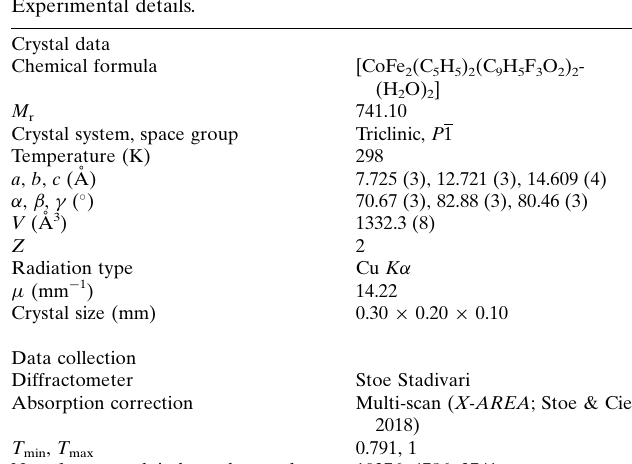
Table 2 Experimental details.